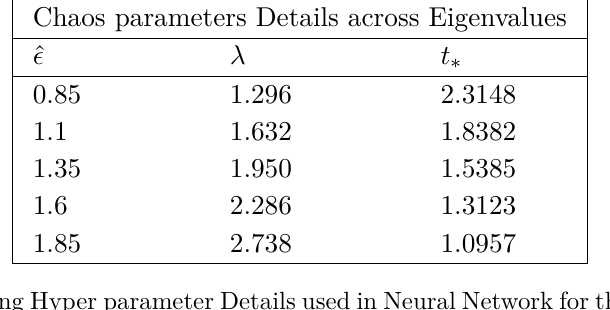
Table 1 . Table showing Hyper parameter Details used in Neural Network for three different number of